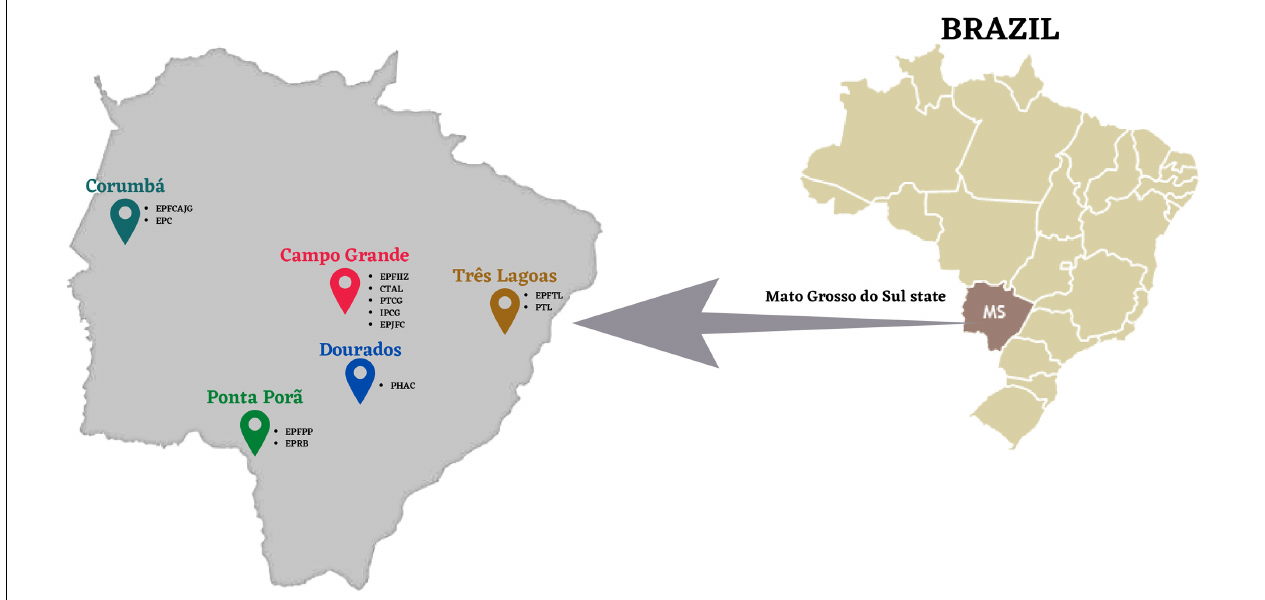
FIGURE 1 | The geographic location of study prisons, Mato Grosso do Sul State, Brazil (Adapted from Puga et al., 2017).